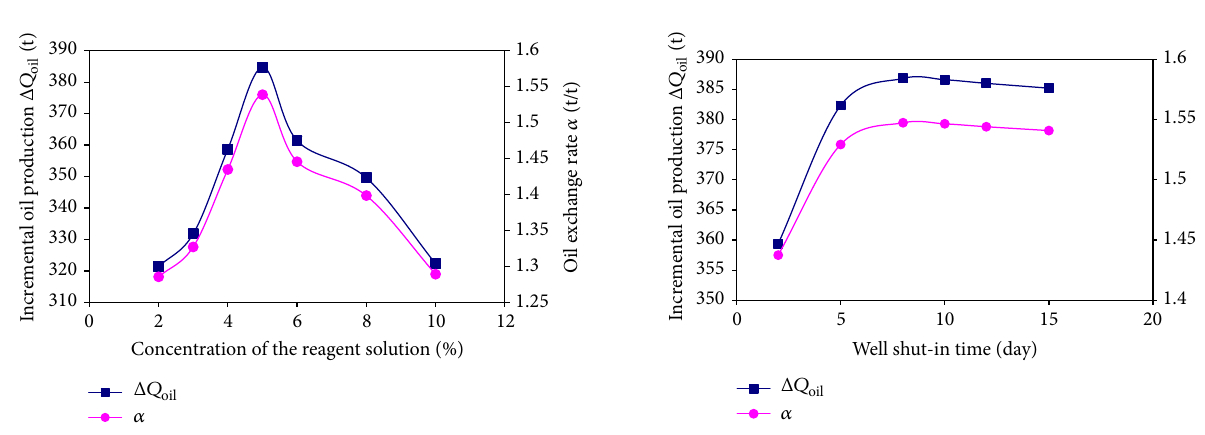
Figure 12: Variations of the incremental oil production and oil exchange rate at different reagent solution mole concentrations.